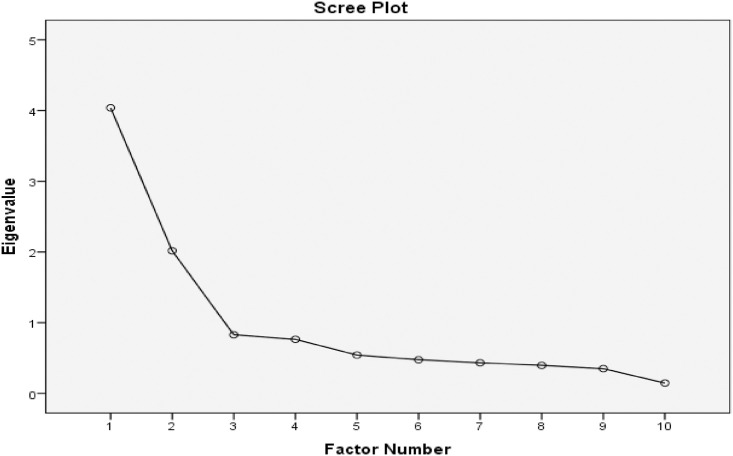
The number of constructs in the Patient-Medication Adherence Instrument (P-MAI).